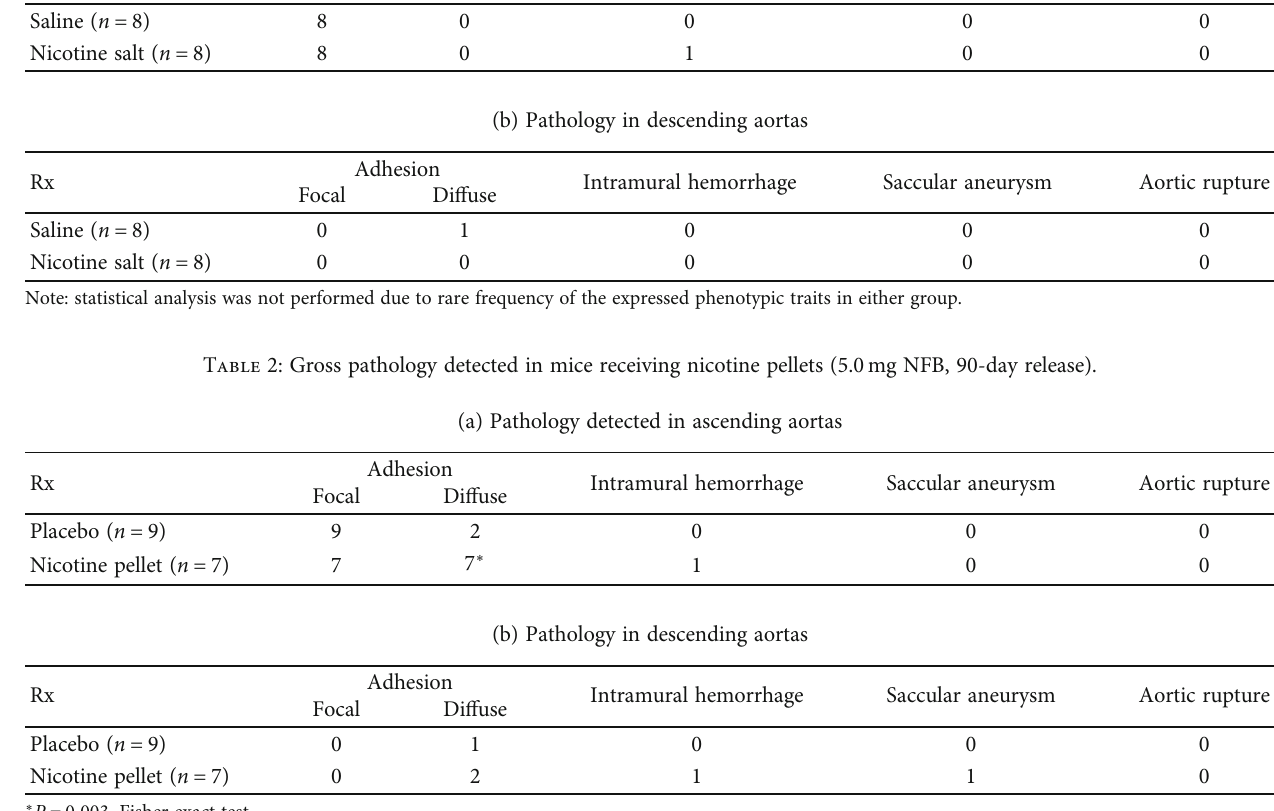
Table 3: Gross pathology detected in the ascending aorta of mice receiving saline or NFB (3.0 mg/kg/day) plus BAPN. Rx